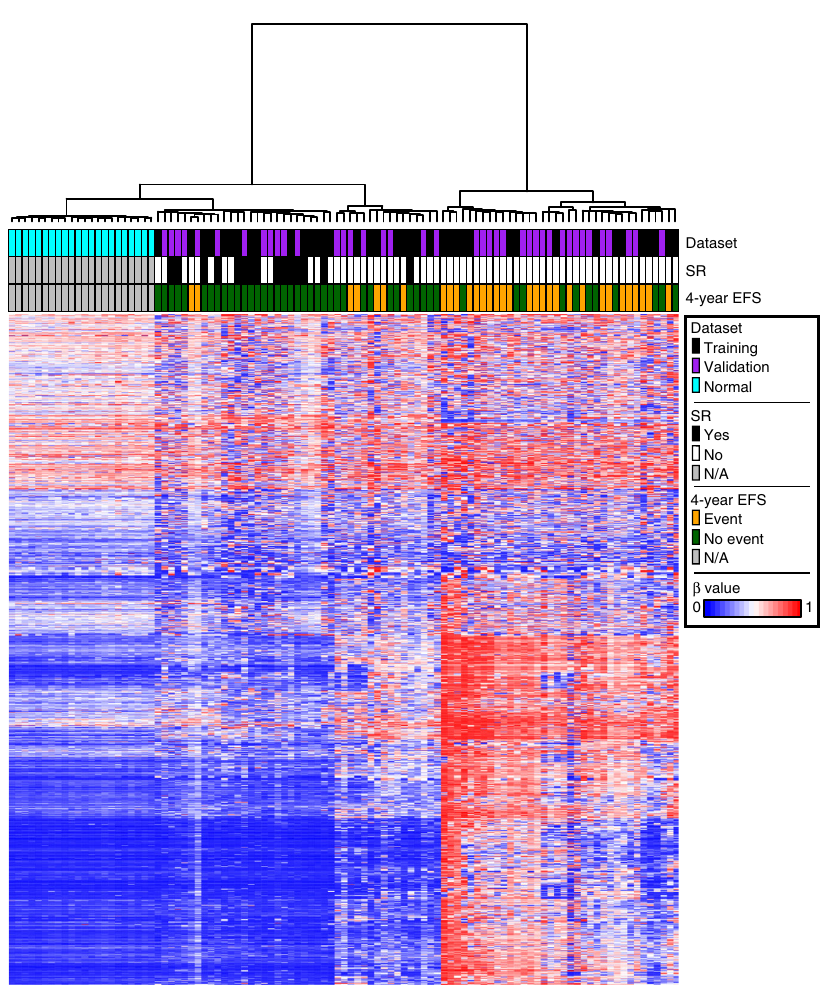
Fig. 3 Patients experiencing spontaneous resolution cluster closer to healthy age-appropriate controls. Twenty-two healthy, age-appropriate controls were analyzed together with the 79 JMML patients from the combined discovery and validation cohorts. Patients and controls are displayed on the X axis and the same 1527 most variable CpG sites from the unsupervised discovery cohort analysis are displayed on the Y axis. HgB F fetal hemoglobin, SR spontaneous resolution, EFS event-free survival, β beta value, N/A not